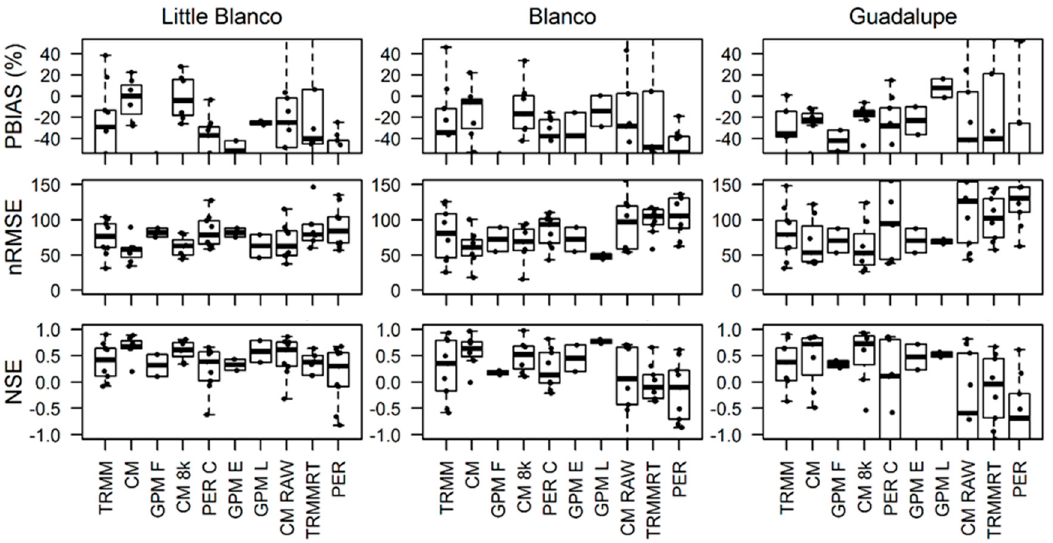
Figure 7. Boxplots for hydrograph performance statistics for all spatial domains. X -axis labels abbreviations and boxplot representations are the same as those described in Figure 4.